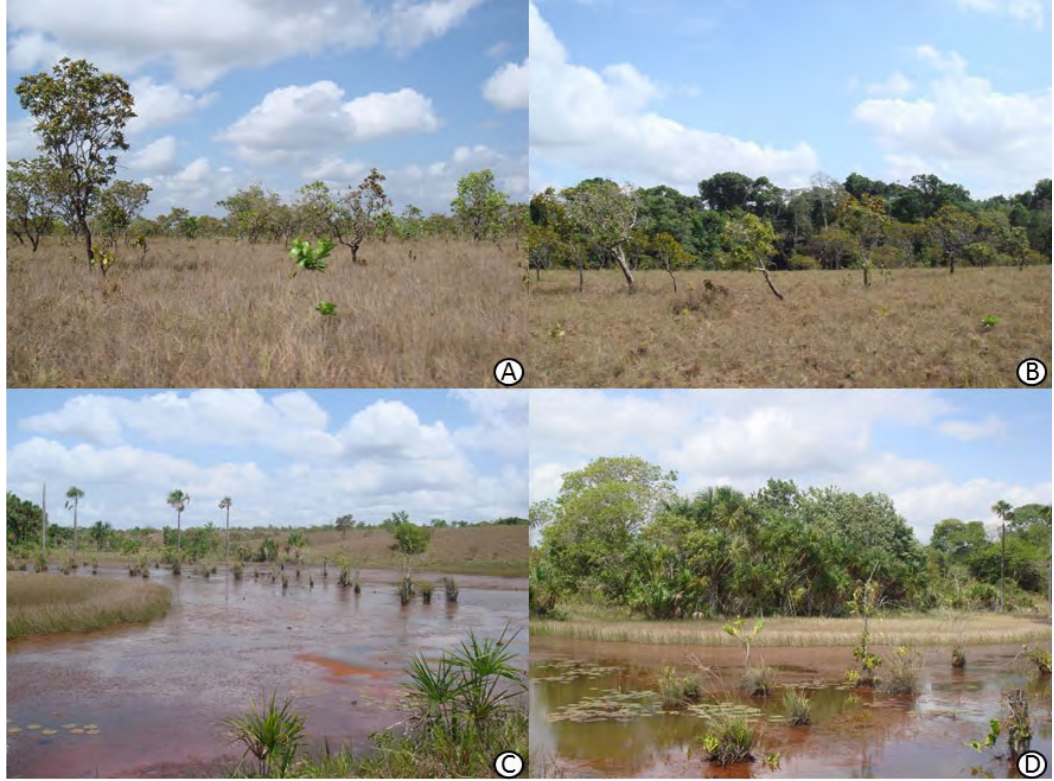
Figure 2. Breeding habitats of Elachistocleis helianneae : ( A ) scrub grassland savanna; ( B ) parkland savanna; ( C ) and ( D ) permanent ponds in Amazon